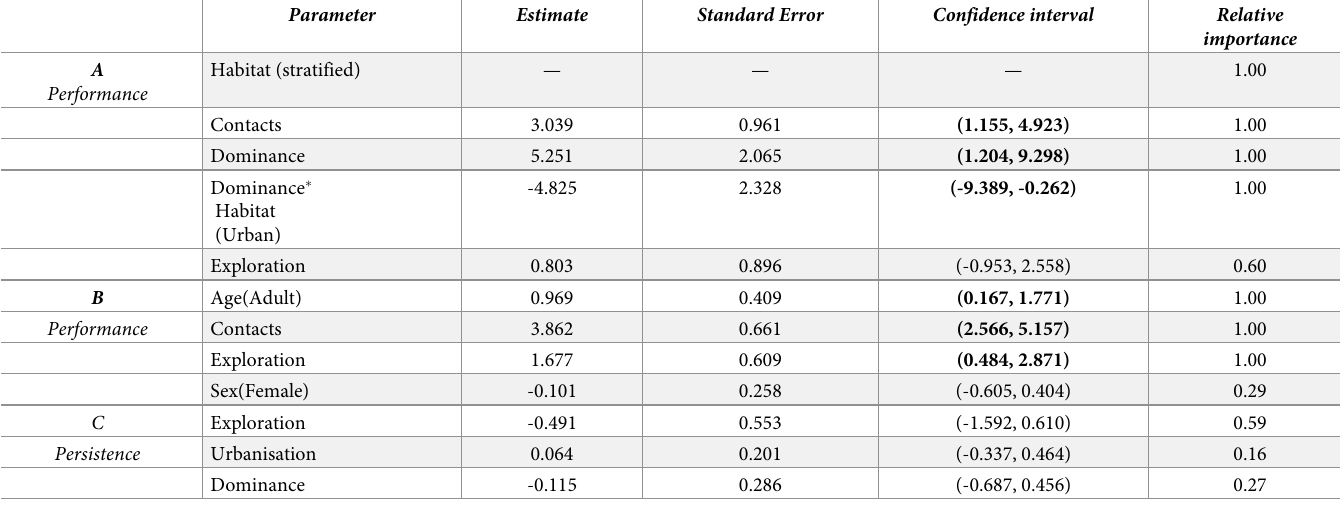
Table 1. Model averaged estimates assessing the influence of predictors on (A) lever-pulling performance (n = 38 individuals, solutions = 22), (B) lever-pulling per- formance after replacing dominance with age and sex in the global model (n = 52 individuals, solutions = 33), and (C) persistence in the lever-pulling task (n = 39 individuals).